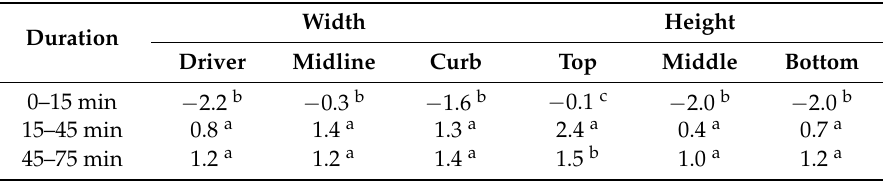
Table 8. Effect of trip duration on elevated temperature above ambient ( ∆ t, ◦ C) at measured locations across width and height of the trailer when cooling assistance was used ( n = 8). Cooling assistance consisted of propeller fan(s) blowing air and misters or hand-held pressure washers applying water toward trailers being loaded.